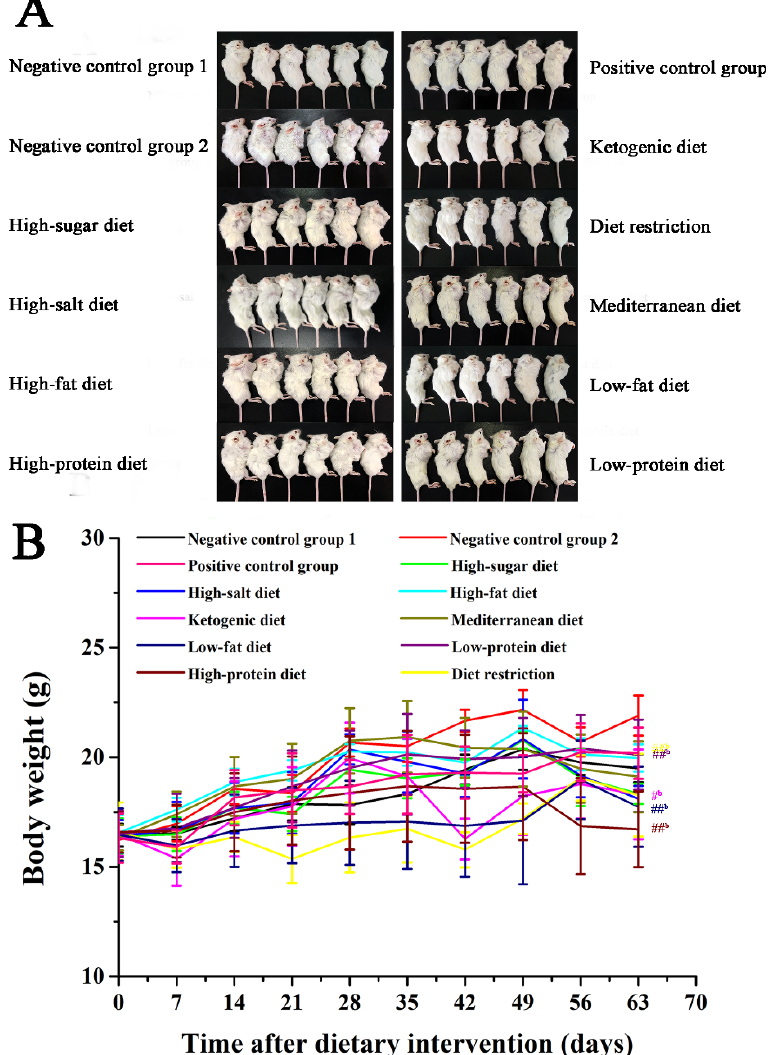
Figure 1. Effects of different dietary patterns on body weight. ( A ) Images of tumors in mice, n = 6. ( B ) Mice weights were recorded every 7 days. #b p < 0.05 and ##b p < 0.01 compared with negative control group